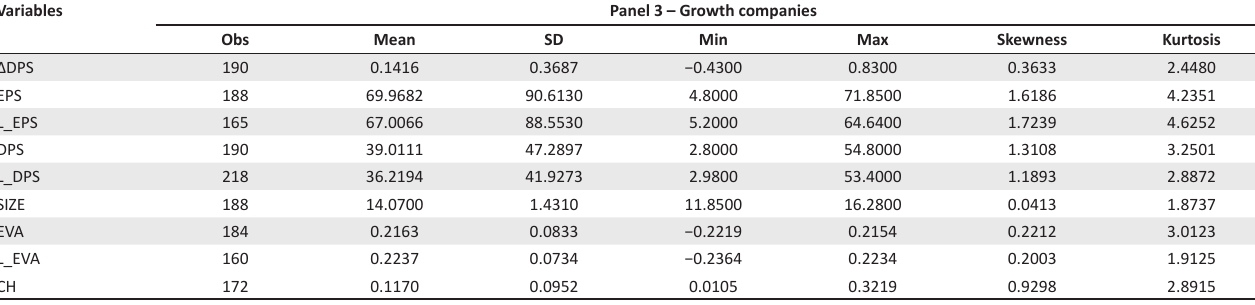
TABLE 4: Descriptive analysis for all variables of Panel 3–Growth companies. Variables